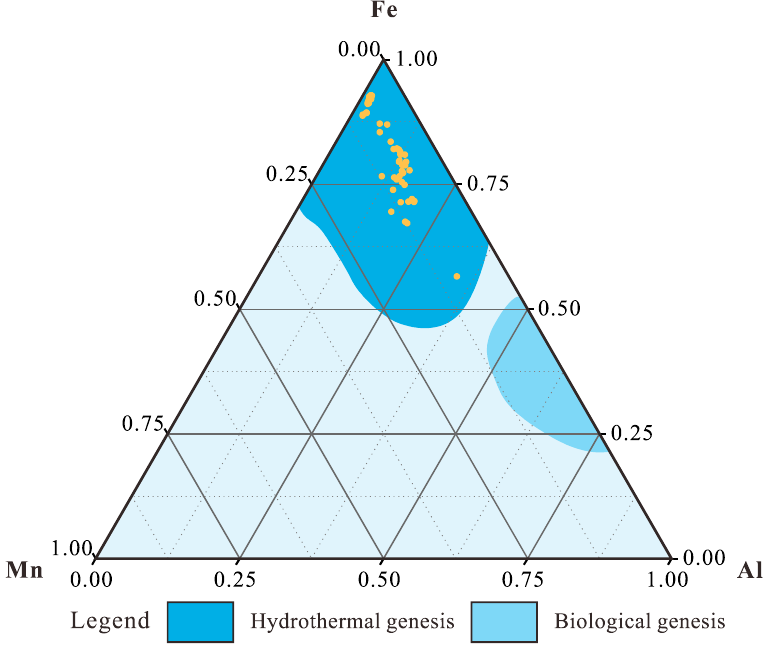
Figure 3. The genesis analysis of the excess silicon of the Xinkailing Fm. and the first member of the Lishuwo Fm. in Well X, the Lower Yangtze. See Figure 1 for the well location.